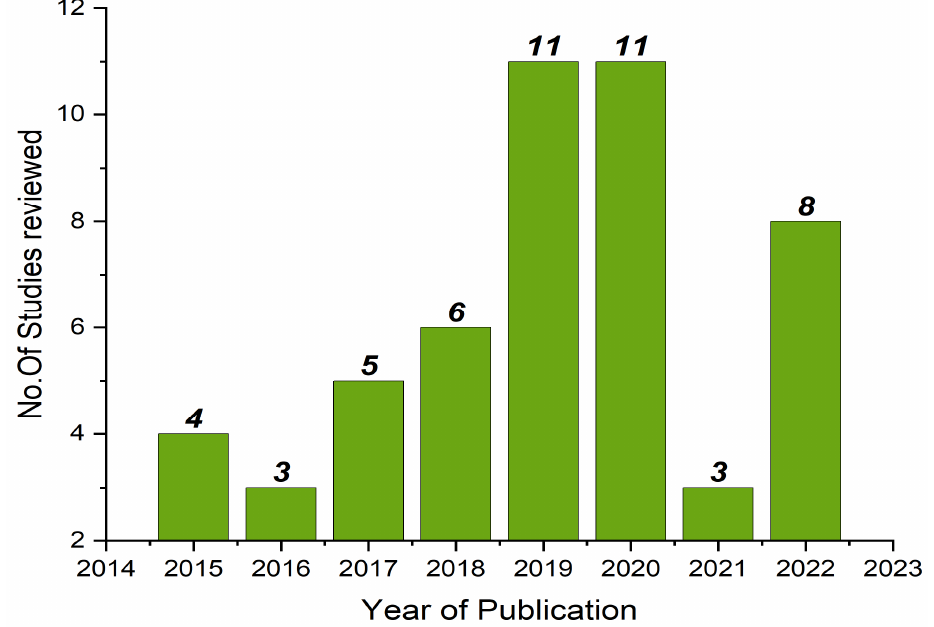
Figure 1. Graph showing number of papers reviewed and their date of publication .